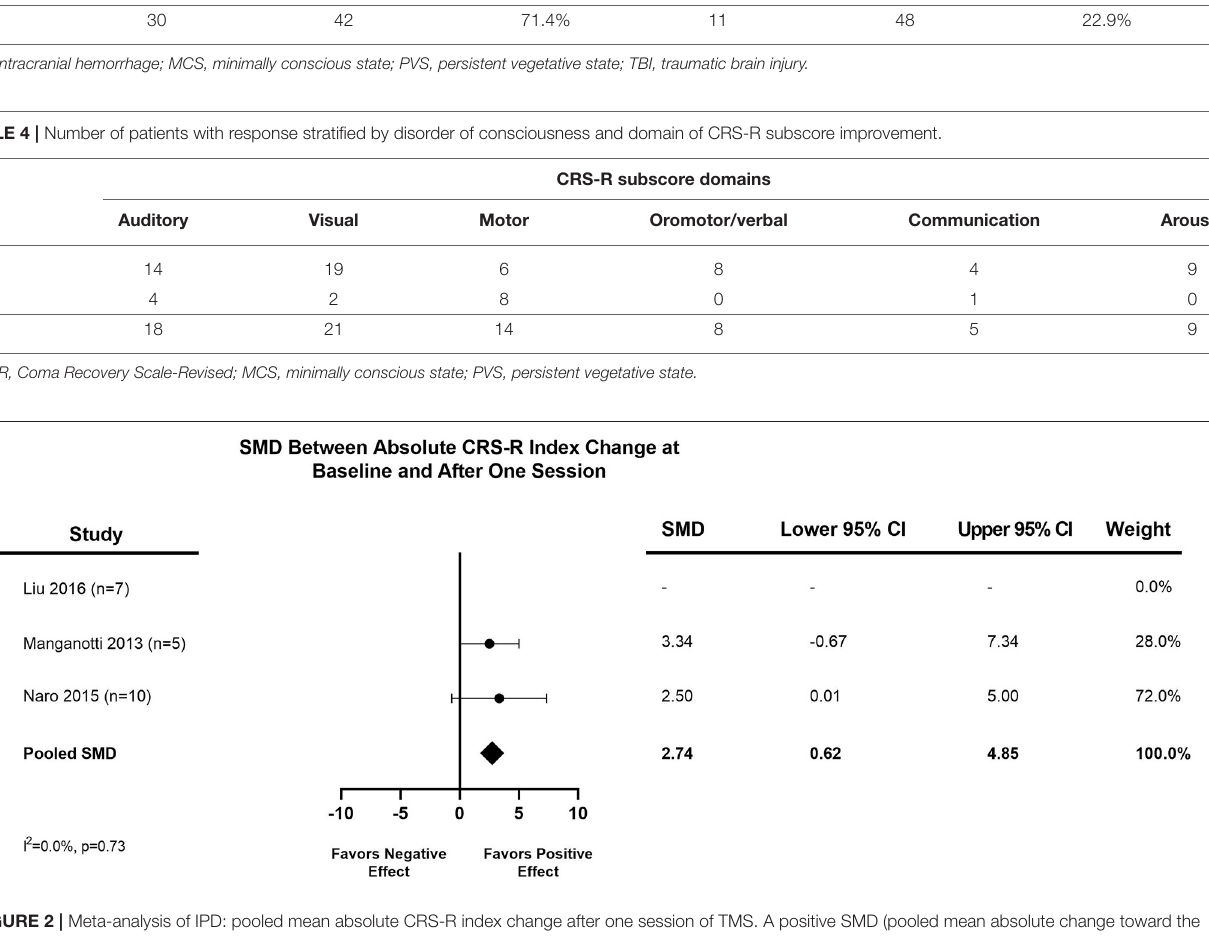
FIGURE 2 | Meta-analysis of IPD: pooled mean absolute CRS-R index change after one session of TMS. A positive SMD (pooled mean absolute change toward the right of the figure) favors a positive effect for TMS, while a negative SMD (pooled mean absolute change toward the left of the figure) favors no effect or a negative effect for TMS. CI, Confidence Interval; CRS-R, Coma Recovery Scale-Revised; DoC, Disorder of Consciousness; SMD, standardized mean difference; TMS, Transcranial magnetic stimulation.